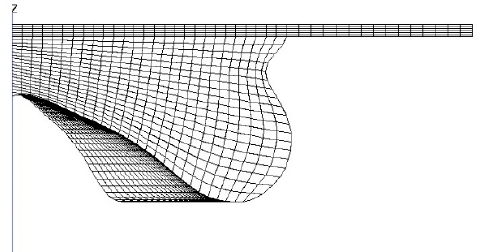
Figure 1. Computational grid at the TDC.